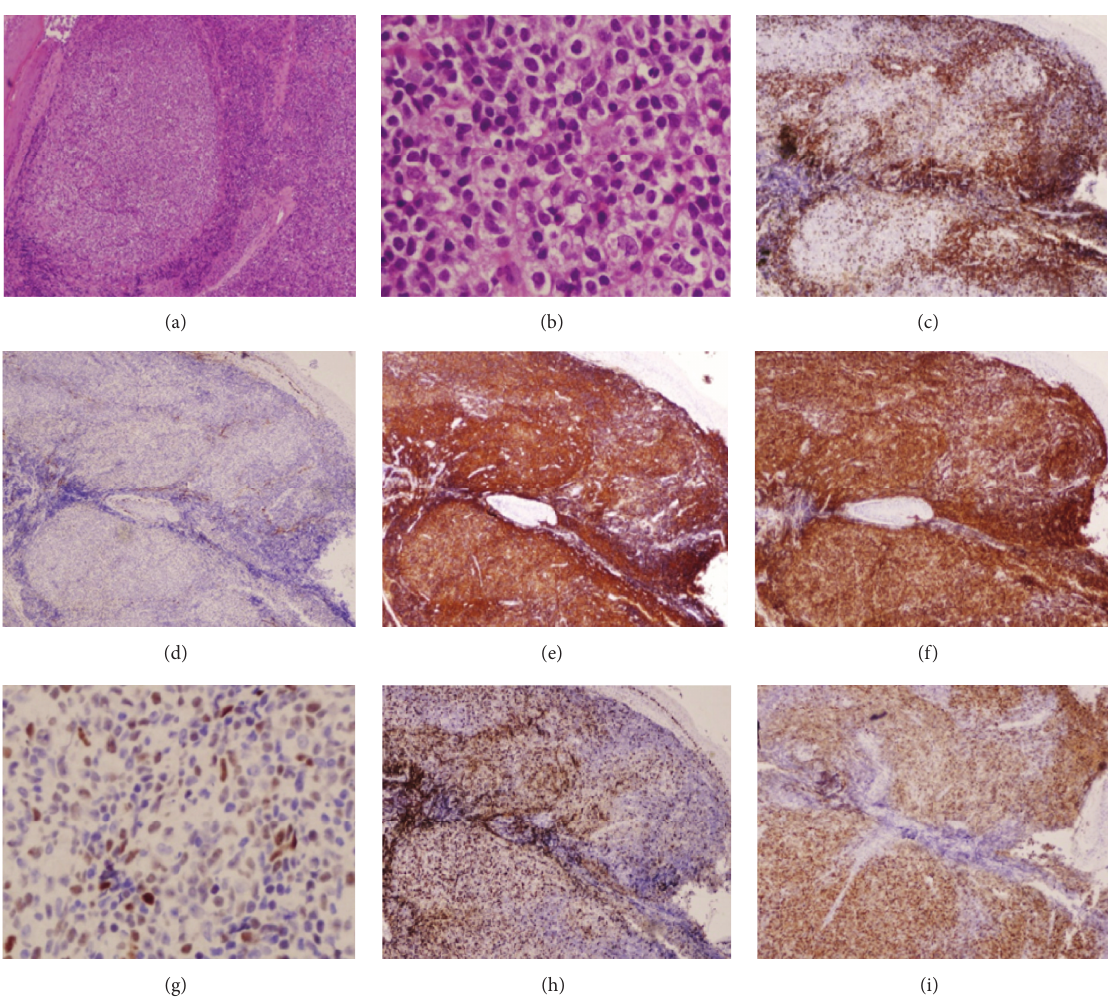
Figure3:PermanentsectionsshowinghistologyofB-celllymphoma;lowpower(a)andhighpower(b)showthetypicalhistologicalstructure. Further immunostainings of the mass for typical lymphoma markers, including CD3 (c), CD10 (d), CD20 (e), BCL2 (f), BCL6 (g), Ki67 (h), and MUM1